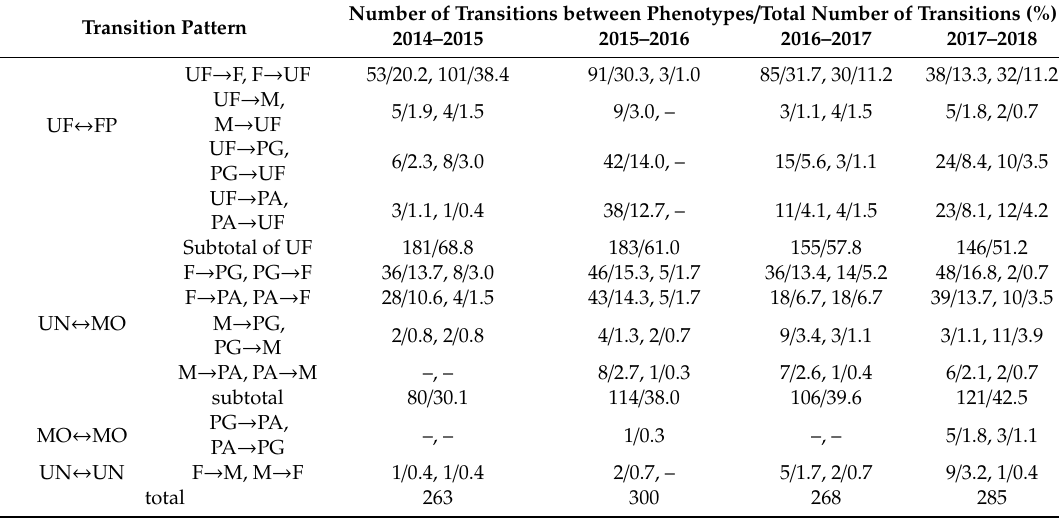
Table 2. Transitions between flowering phenotypes in the juvenile plantation of C. paliurus.